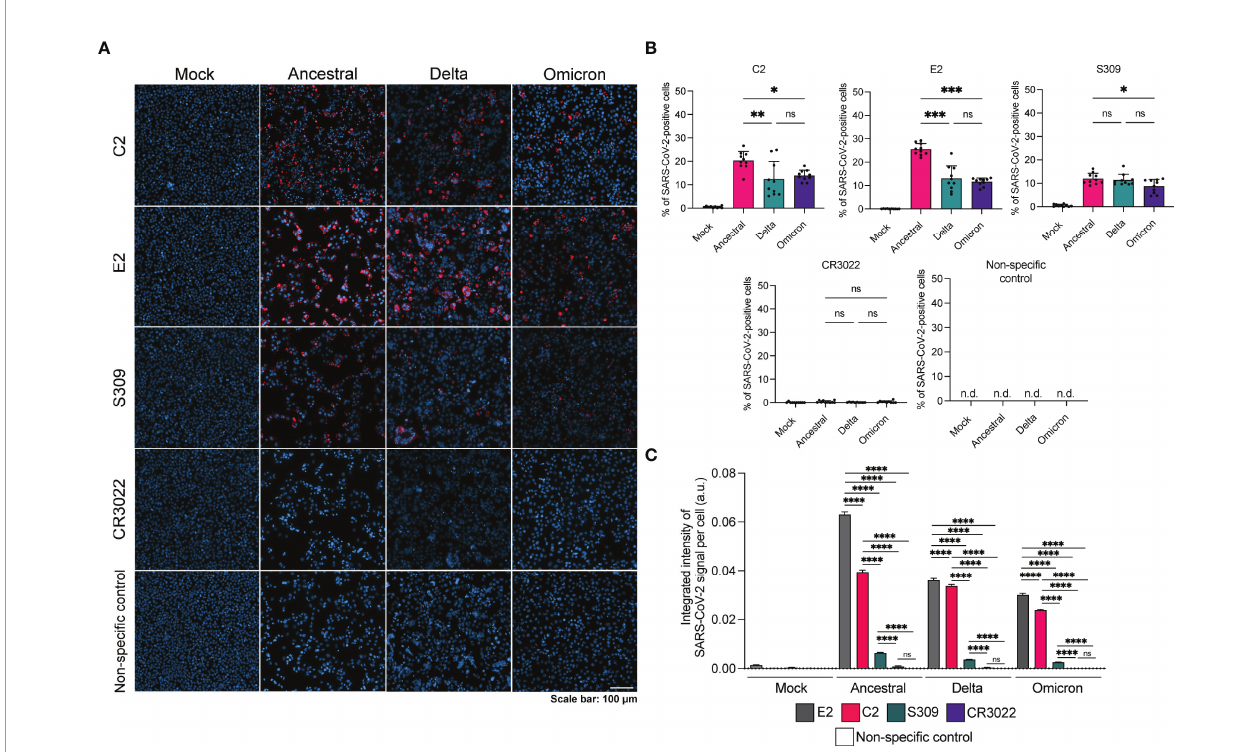
FIGURE 3 | Detection of SARS-CoV-2 variants by N-speci fi c nanobodies via IFA. (A) Representative IFA images of infected Vero E6 cells stained with antibody or nanobody (red) and Hoescht stain (blue). Non-speci fi c control is a Nipah F speci fi c mAb 5B3. (B) Quanti fi cation of percentage of SARS-CoV-2 positive cells per region of interest (n=10) for each staining method. (C) Integrated intensity of SARS-CoV-2 signal per cell per strain for each staining method. Number of cells analyzed per condition is as follows: mock infected, E2 n=36,393; mock infected, C2 n=34,712; mock infected, S309 n=36,360; mock infected, CR3022 n=35,700; mock infected, non-speci fi c n=37,166; ancestral, E2 n=9621; ancestral, C2 n=9699; ancestral, S309 n=18,088; ancestral, CR3022 n=7650; ancestral, non-speci fi c n=24,307; delta, E2 n=19,517; delta, C2 n=18,359; delta, S309 n=23,476; delta, CR3022 n=19,104; delta, non-speci fi c n=27,871; omicron, E2 n=19,359; omicron, C2 n=29,133; omicron, S309 n=11,565; omicron, CR3022 n=26,210; omicron, non-speci fi c n=22,892. Statistics were performed using a one-way ANOVA with Tukey ’ s multiple comparisons test where *, p < 0.05, **, p < 0.005, ***, p < 0.001, ****, p < 0.0001, ns, non-signi fi cant and n.d., not